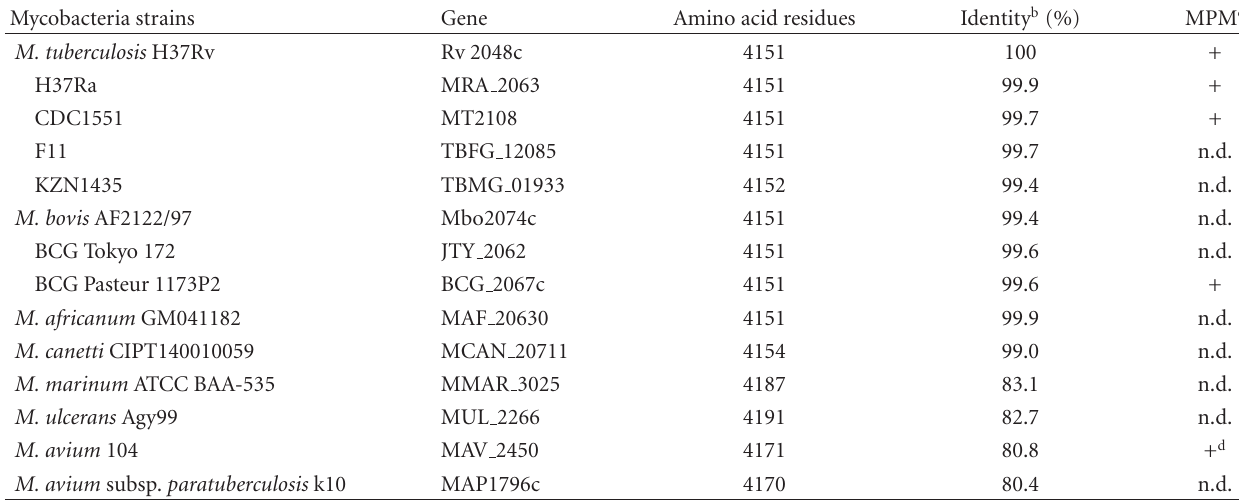
Table 1: Distribution of pks12 gene in mycobacteria species a